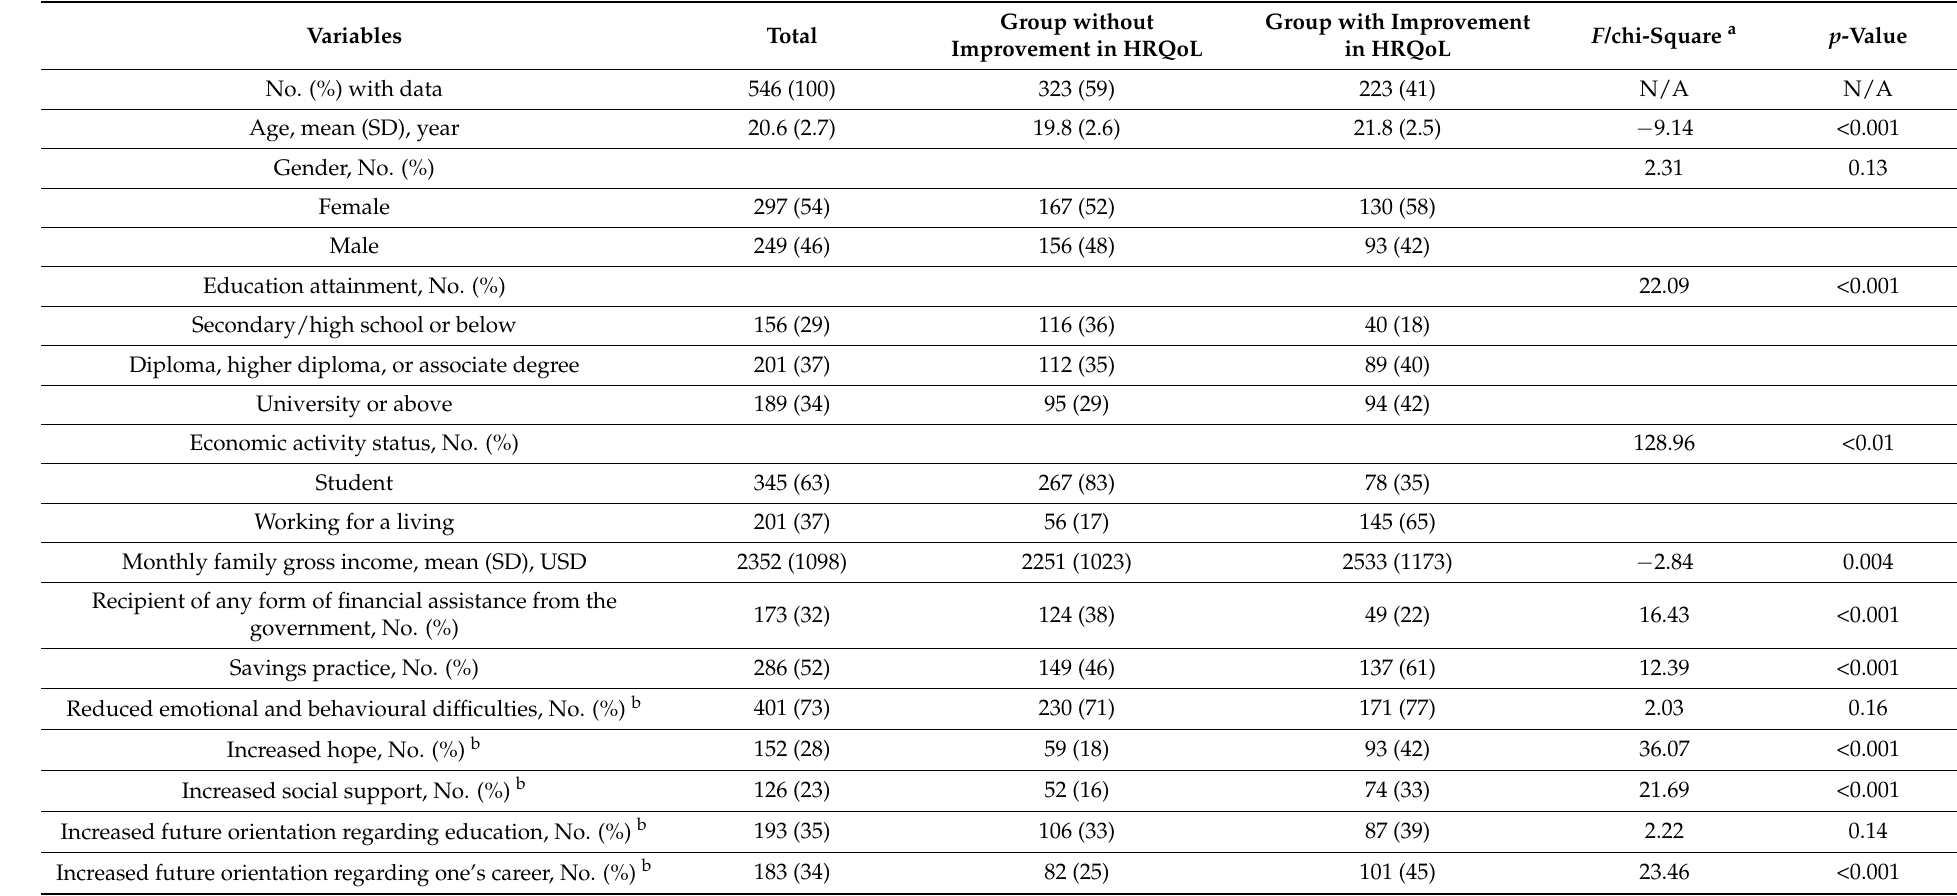
Table 1. Summary of demographic characteristics and other financial and psychological variables by group of